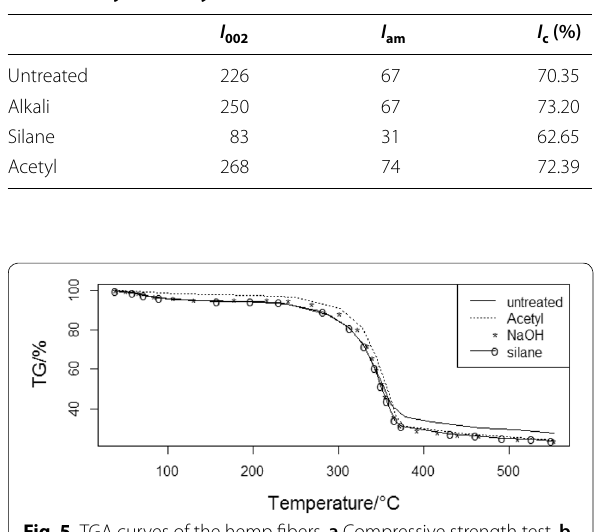
Table 5 Crystallinity index of fibers.